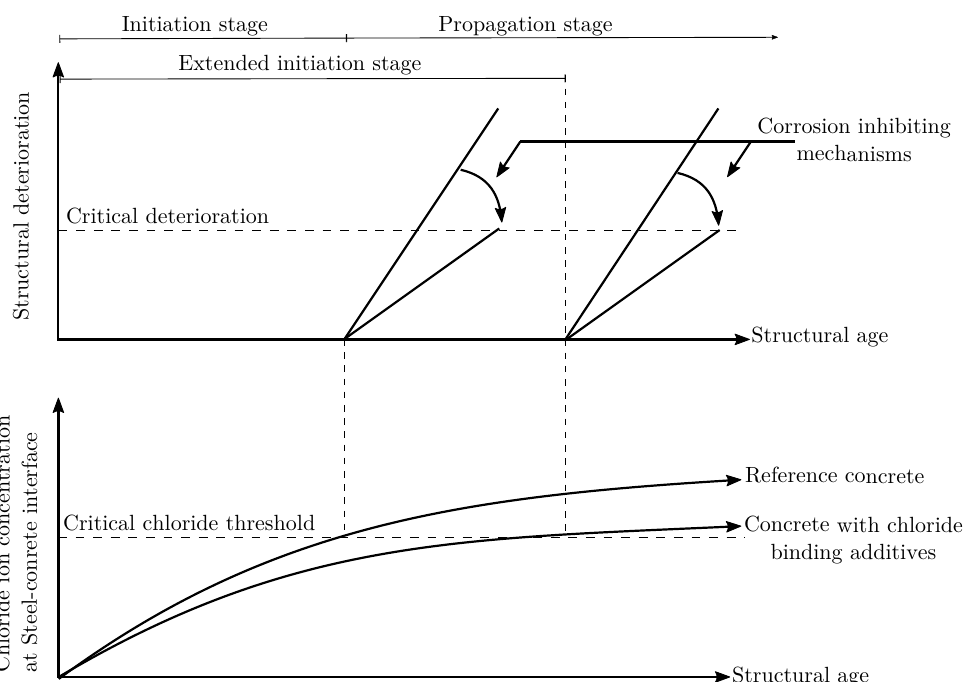
Figure 1. Schematic representation of service life stages of concrete structures under chloride induced corrosion and associated chloride profiles based on modified Tuutti’s diagram